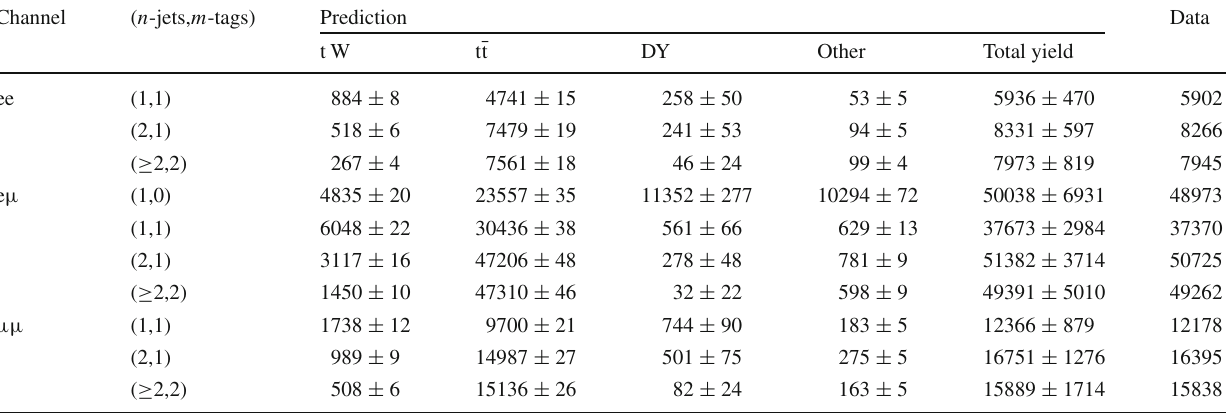
Table 2 Number of expected events from tW, t ¯ t and DY production, from the remaining backgrounds (other), total background contribu- tion and observed events in data after all selections for the ee, e μ , and μμ channels and for different ( n -jets, m -tags) categories. The uncer-